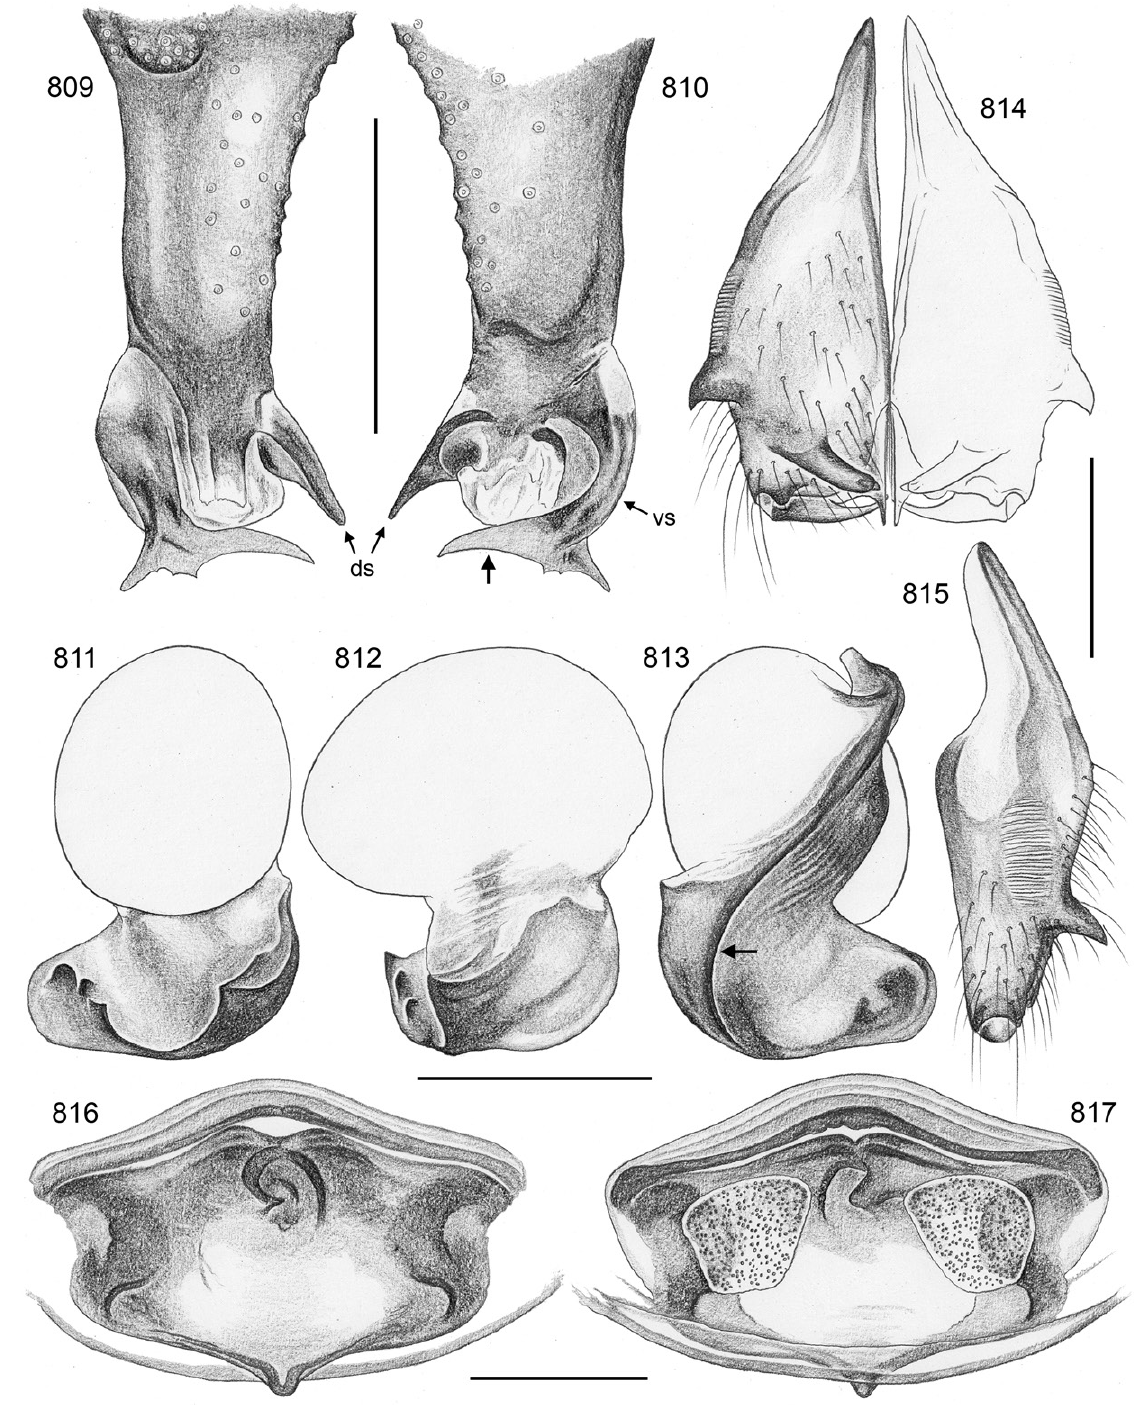
Figs 809–817. Crossopriza surobi sp. nov.; non-type male and female from Afghanistan, SE of Surobi (MHNG). 809–810 . Left procursus, prolateral and retrolateral views; arrow: branch of ventral sclerite. 811–813 . Left genital bulb, prolateral, dorsal, and retrolateral views; arrow: retrolateral ridge. 814– 815 . Male chelicerae, frontal and lateral views. 816–817 . Cleared female genitalia, ventral and dorsal views. Abbreviations: ds = dorsal sclerite; vs = ventral sclerite. Scale bars = 0.3